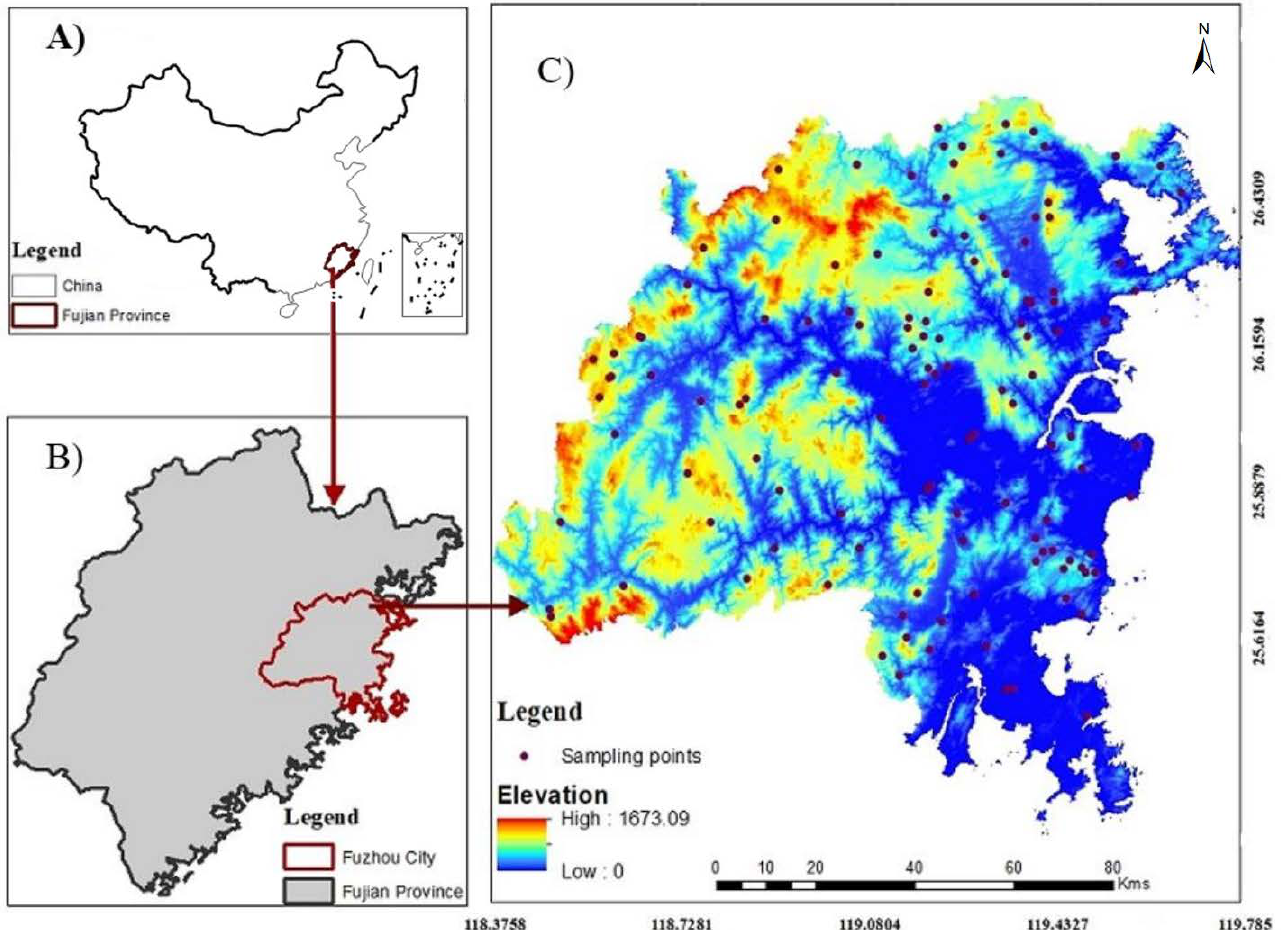
Figure 1. Study area map: ( A ) Fujian province, China; ( B ) Fuzhou, Fujian; ( C ) sample points,